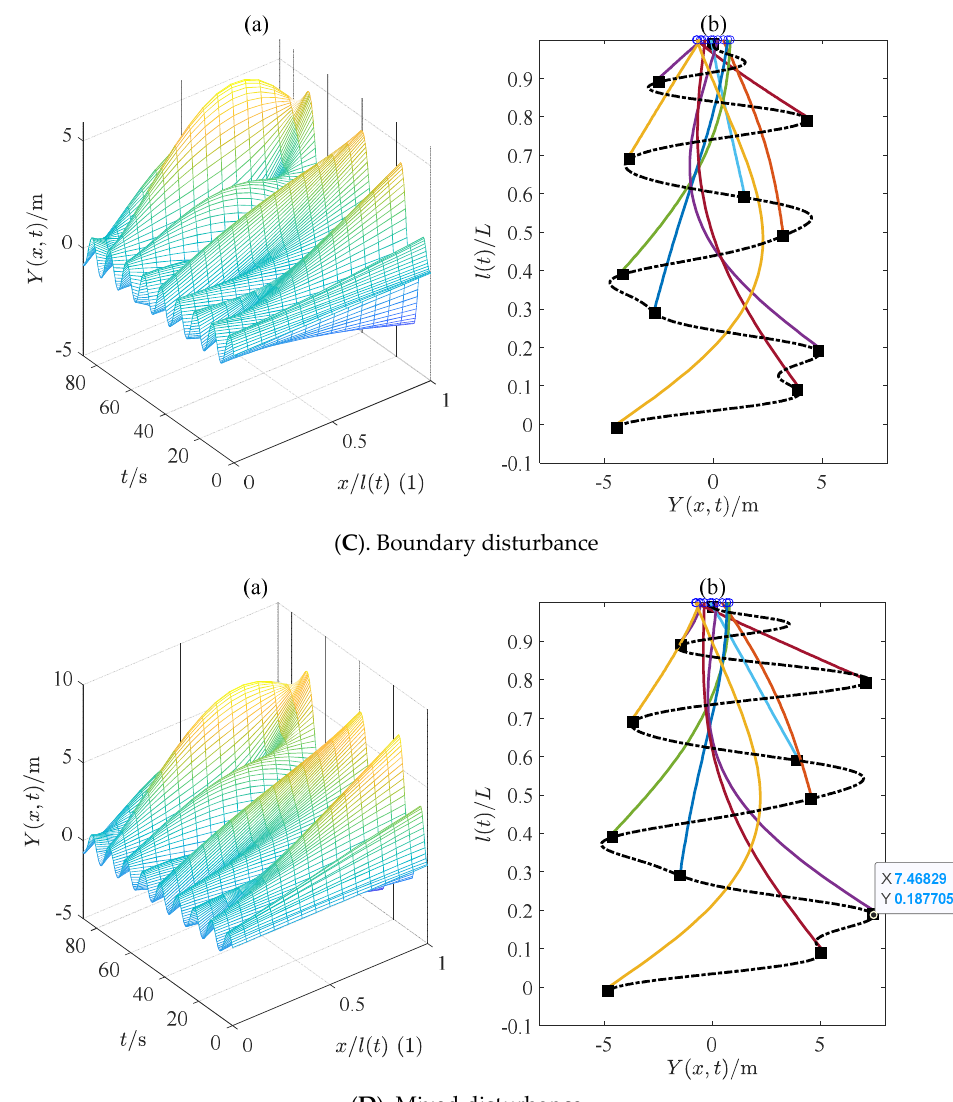
Figure 5. Spatial shape and displacement of the deep-sea robot: ( a ) 3D Spatial shape of the umbilical cable; ( b ) Small black box, solid line and circle line stands for the deep-sea robot, the umbilical cable and the surface vessel, respectively.